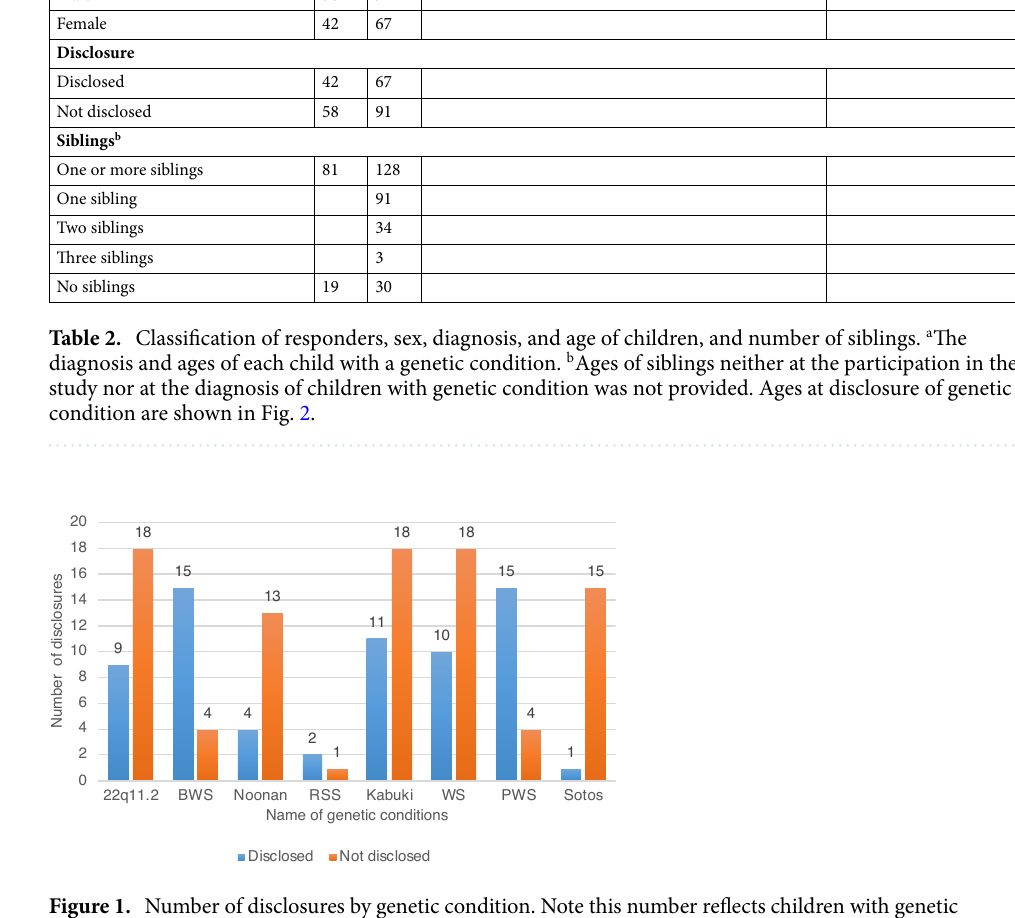
Figure 1. Number of disclosures by genetic condition. Note this number reflects children with genetic